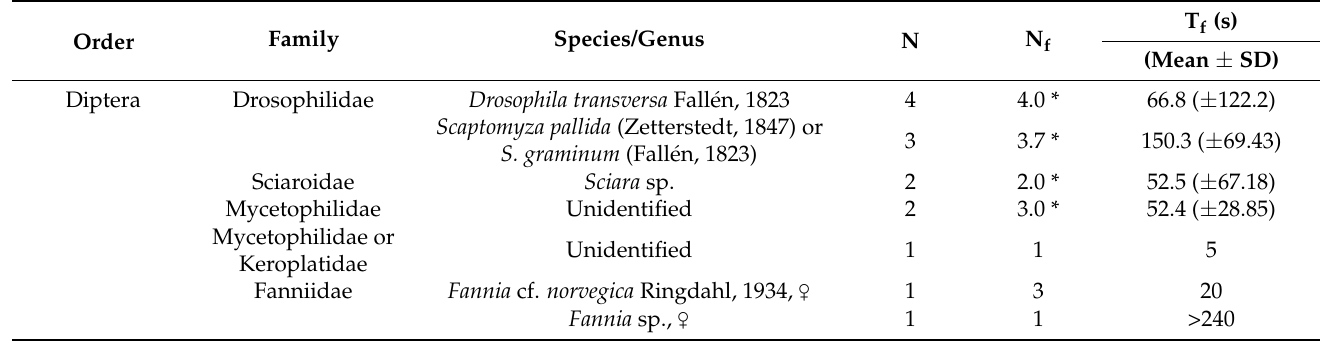
Table 1. Insects visiting Malaxis monophyllos flowers in the studied population with quantitative components of insect